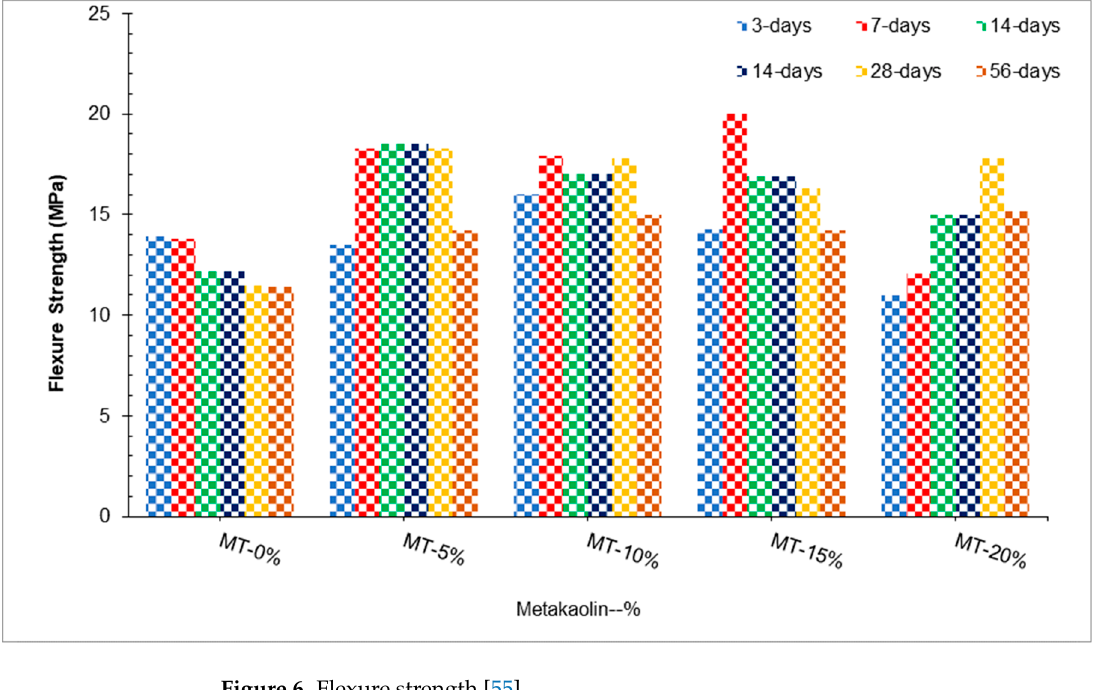
Figure 6. Flexure strength [55].